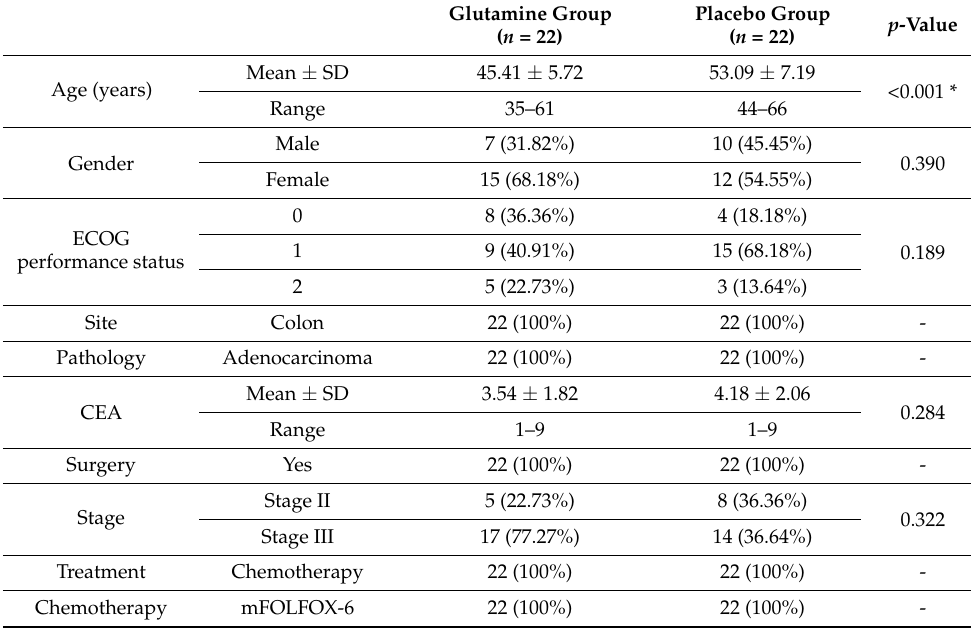
Table 1. Patient characteristics of the studied groups.